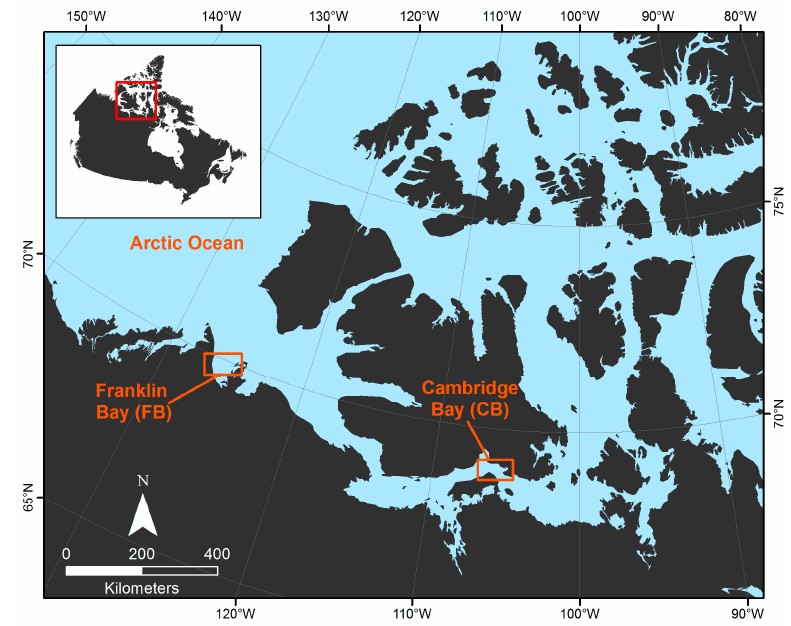
Figure 1. Franklin Bay [2008] and Cambridge Bay [2014 and 2018] case study locations on landfast first-year sea ice in the western Canadian Arctic